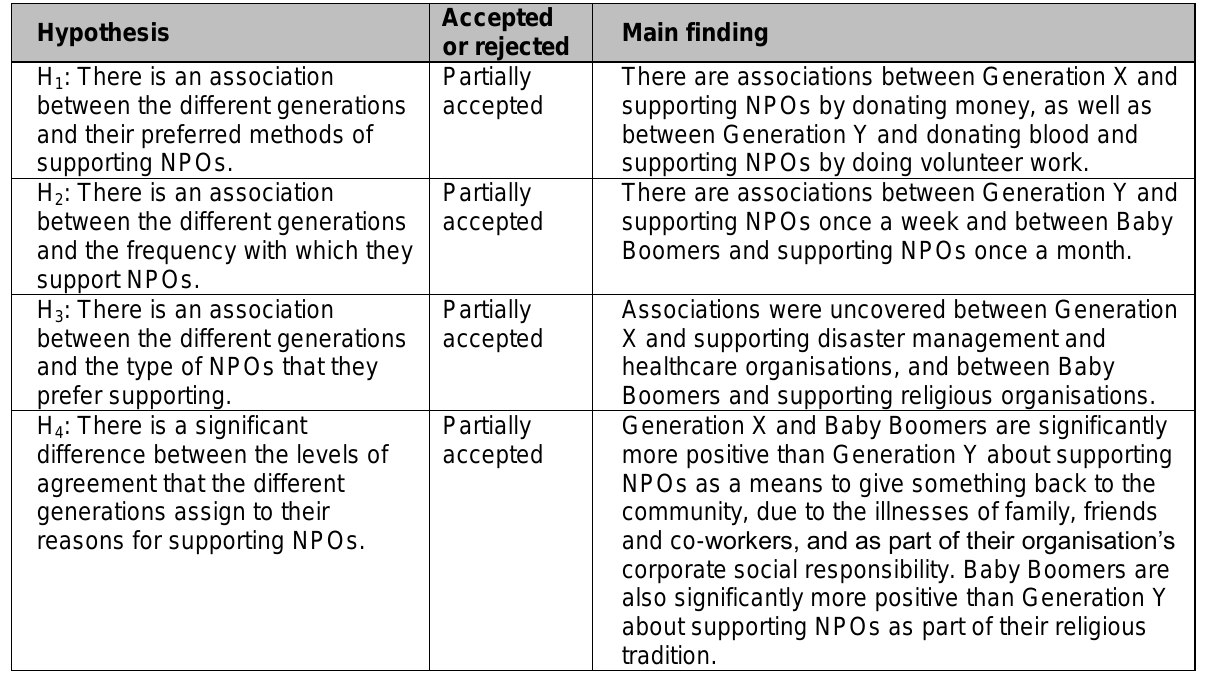
Table 11: Summary of hypothesis testing